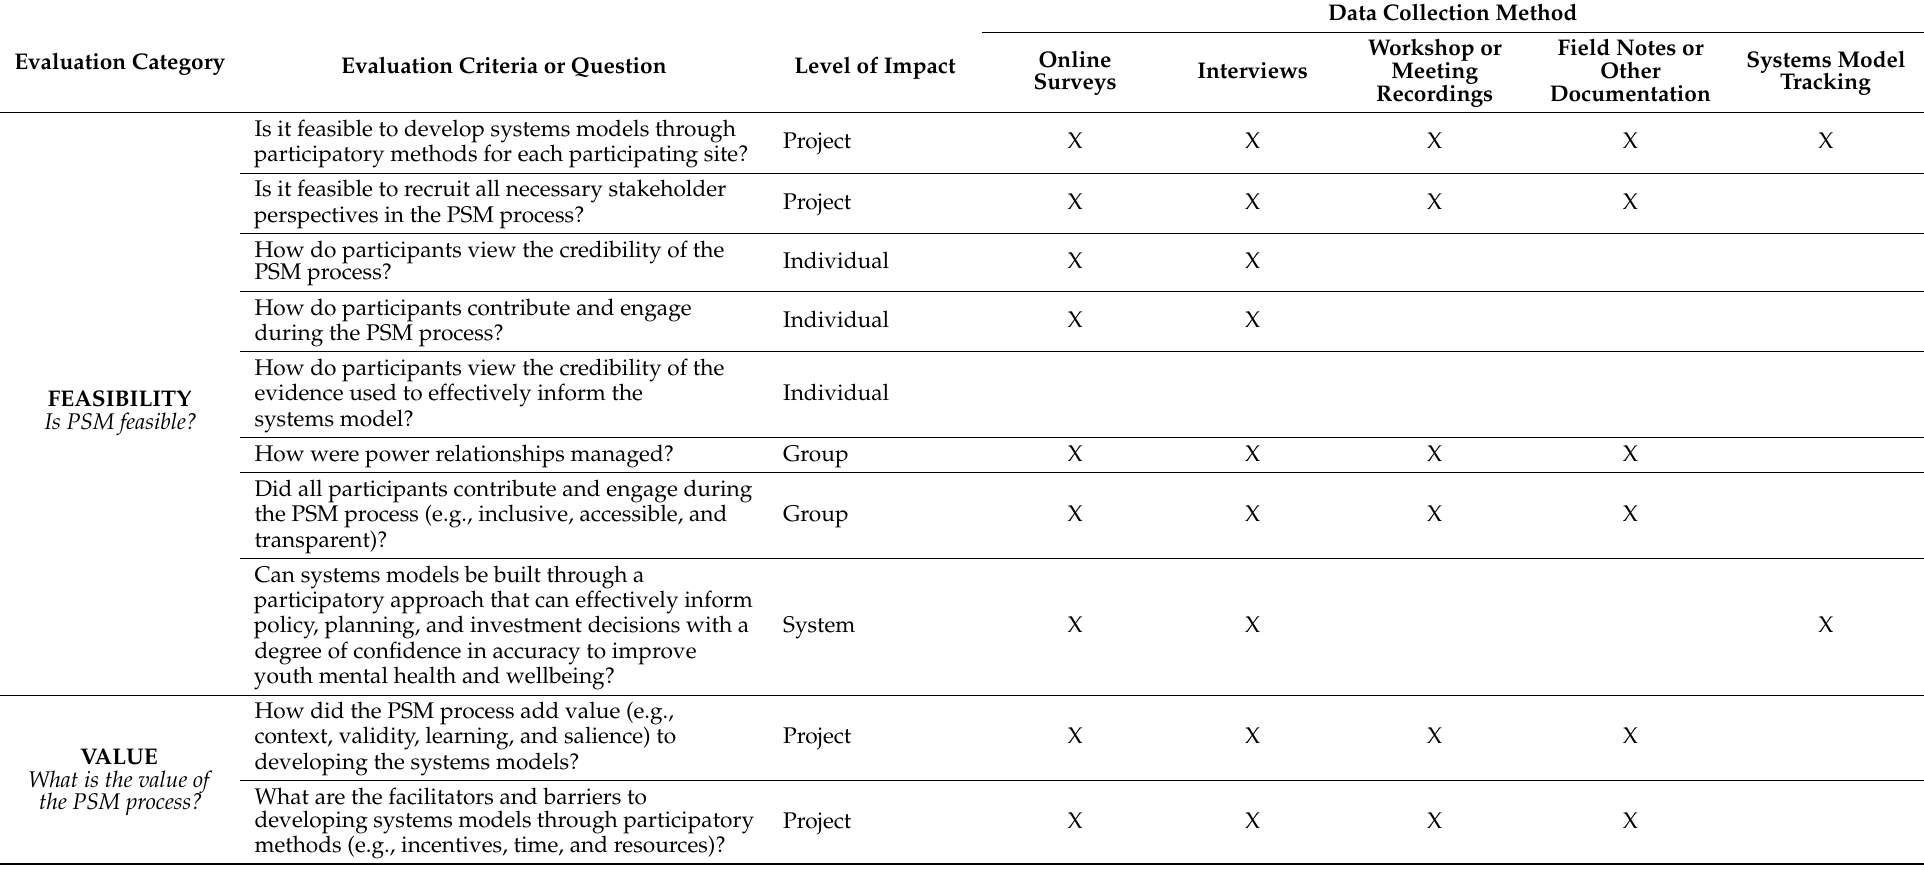
Table 1. Applying a comprehensive multi-scale evaluation framework to collect data utilizing a mixed-methods approach for the Program.